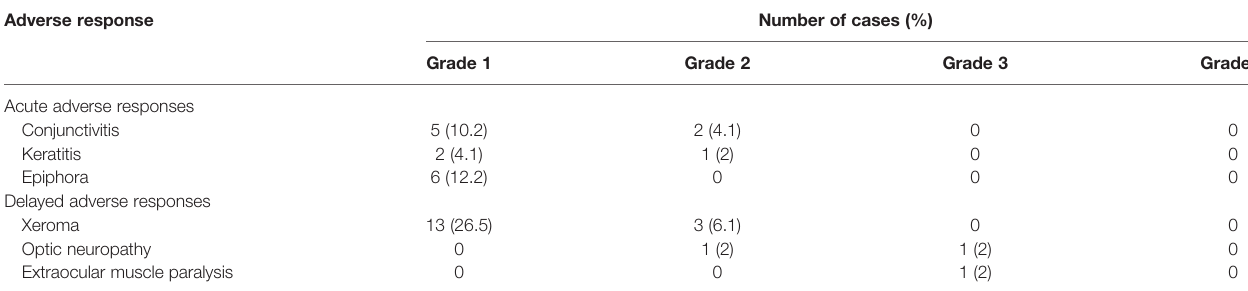
TABLE 4 | Incidence of vision-related adverse